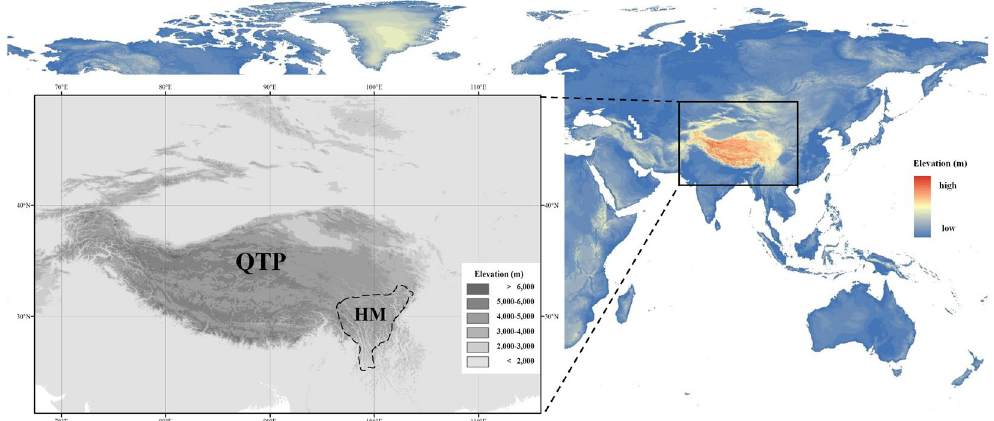
Figure 1. Location and elevation of Rhodiola distributions within the Qinghai-Tibetan Plateau (QTP) and the Hengduan Mountains (HM). Elevation data were downloaded from WorldClim Dataset (www.worldclim.org/ bioclim). The map was processed by ArcGIS ver 10.2 (ESRI, Redlands, California, USA) (http://www.esri.com/).